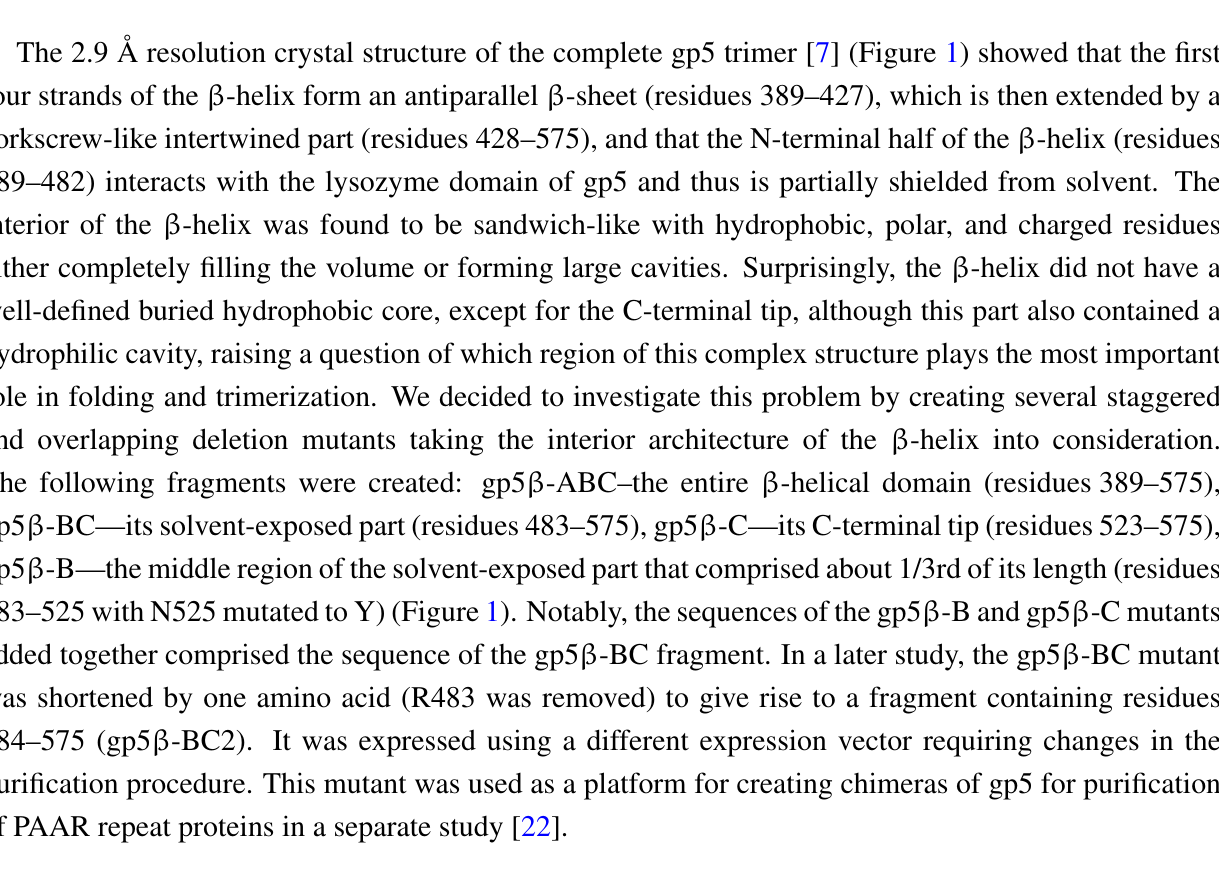
Figure 2. The gp5 β -BC2 fragment was not studied because it is virtually identical to gp5 β -BC. All mutants except gp5 β -C have a pronounced minimum at „ 215 nm that is a characteristic feature of β -structure [39]. The CD spectrum of gp5 β -C is typical for random coil [39] indicating its inability to fold into a β -helical